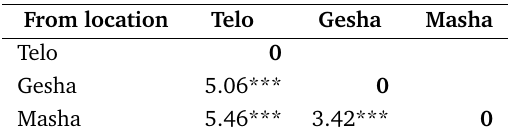
Table 13. Squared Mahalanobis distance between locations; output of the multivariate analysis calculated using the quantitative measurements. *** shows the significance of the distance calculations at p < 0.0001.